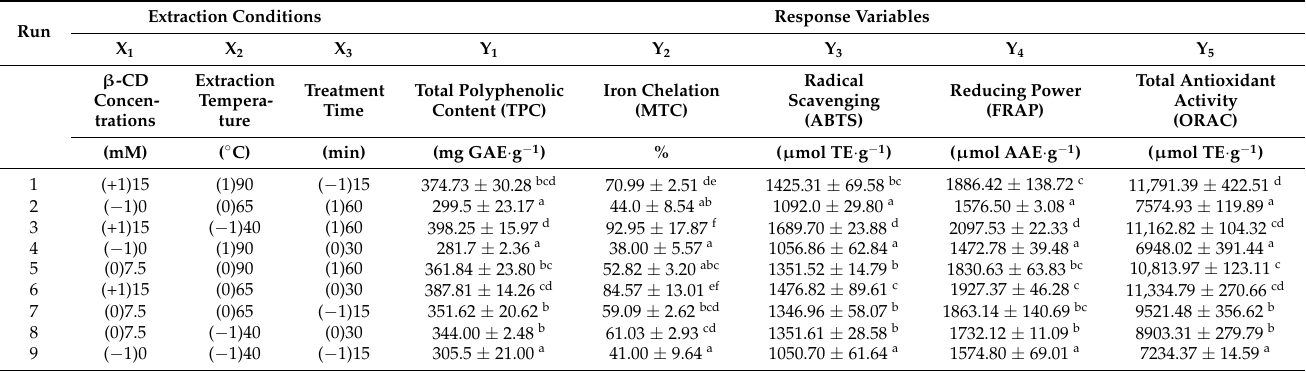
Table 1. Coded independent and response variables for response surface design of crude green rooibos